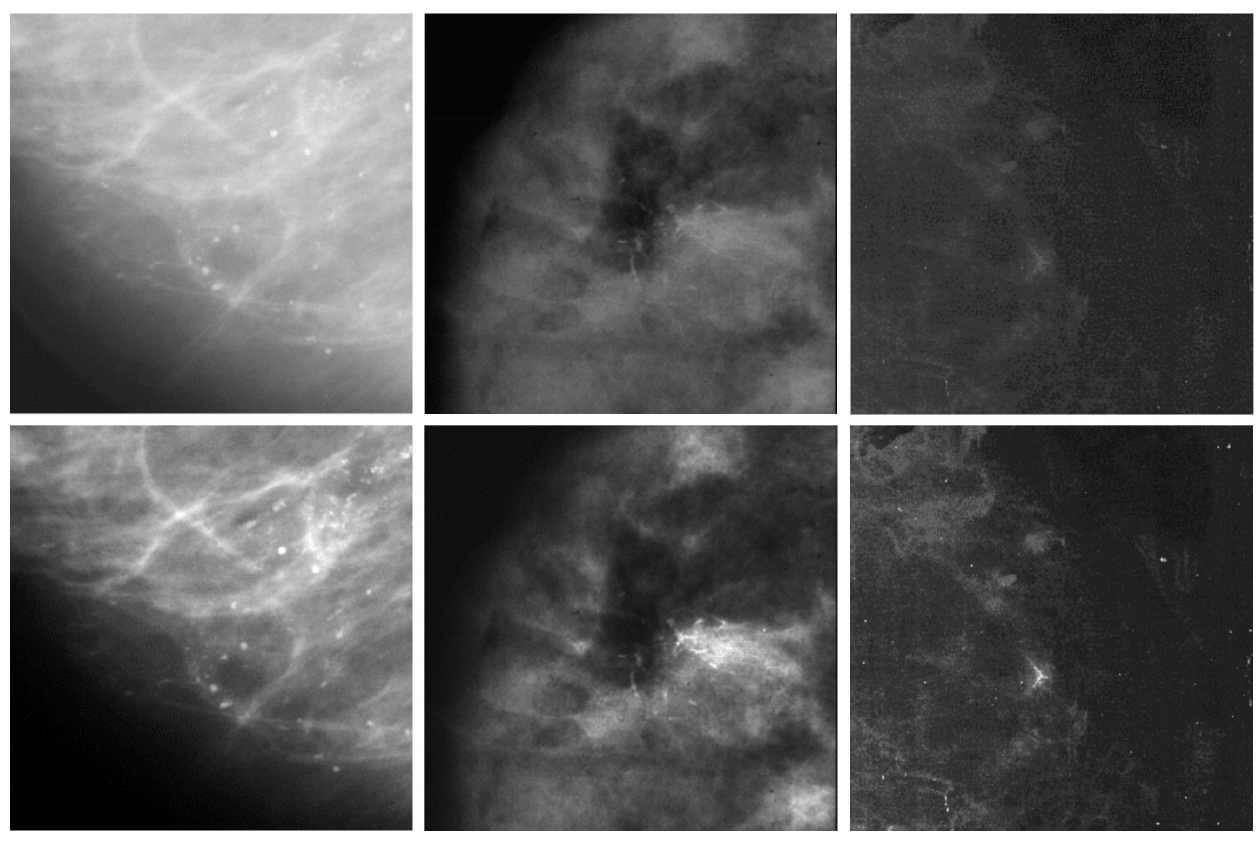
Figure 9. Close-up of malignant abnormalities in mammograms: Case mdb245, MIAS - microcalcification cluster, fatty tissue (left), case #9, UNC Radiology - breast carcinoma (middle), Salus Hospital - stellate patterns (right). Digitized X-ray images by optical scan- ning (top) and digitally restored images